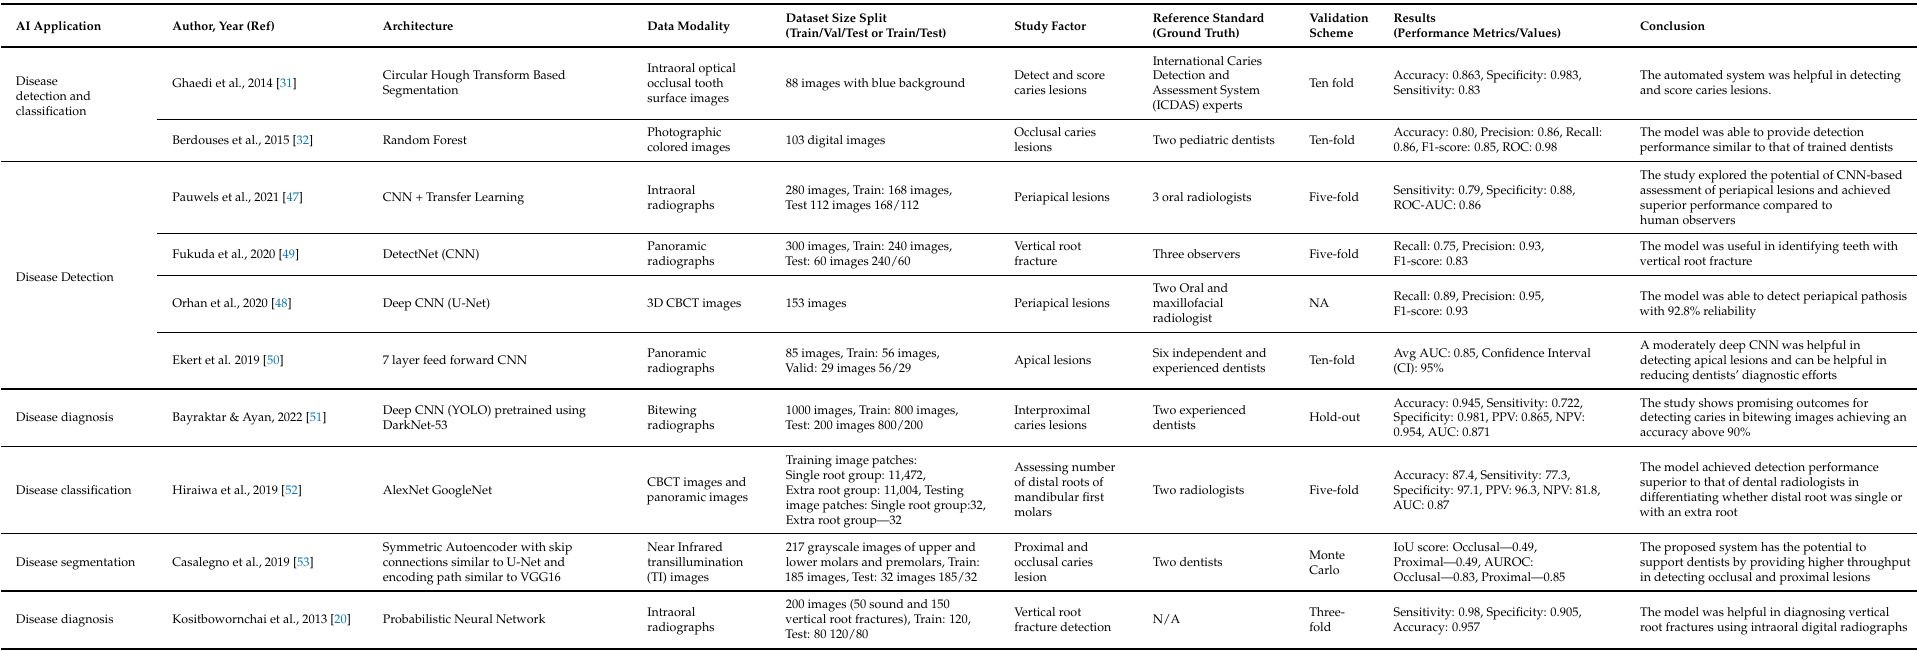
Table 4. Summary of related studies for AI application in